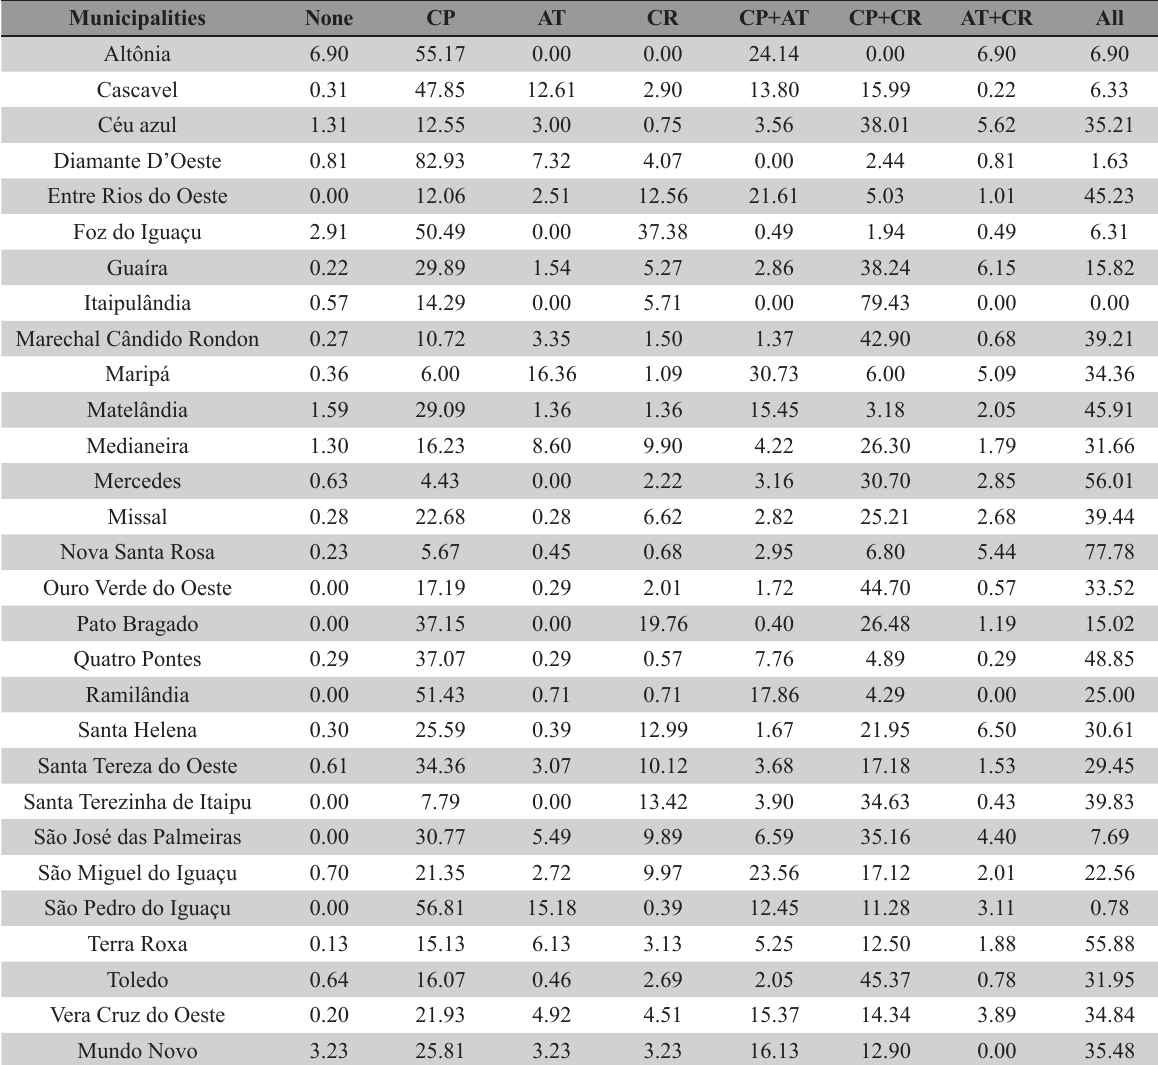
Conservation practices adopted by farms that use NT for annual crops in Paraná Watershed III (expressed as a